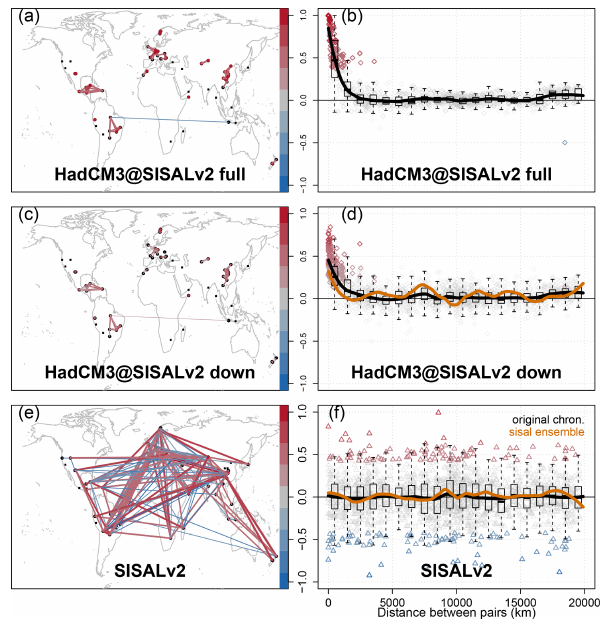
Figure 8. Network spanned by the 5% strongest absolute corre- lations of simulated iHadCM3 LM1 δ 18 O pw at the SISAL cave sites: (a) full (i.e., annual) resolution, (c) down-sampled. All model-based between-site correlations are shown in the distance- binned boxplot (b, d) . Network visualizations (e) and distance- binned boxplot (f) of the cross-correlations between SISAL site δ 18 O speleo for the original age models. The color values indicate the 5% strongest correlations in network and boxplot. The LOESS smoother (span = 0.2) in the boxplots indicates the correlation for the original chronology (black) as well as the absolute highest cor- relation through selection of age models